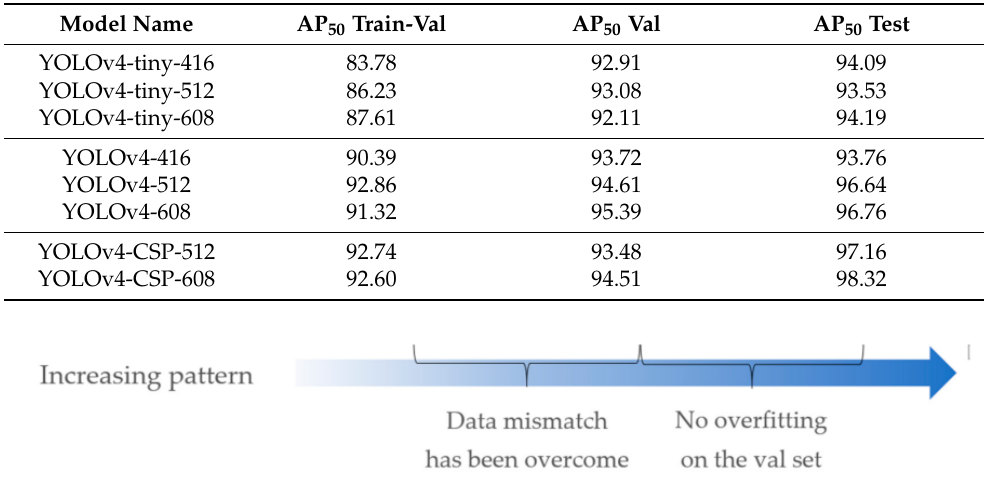
Table 7. Average precision for the training-validation set (train-val), validation set (val), and test set (test) IoU threshold = 50% and Confidence Threshold = 0.5.